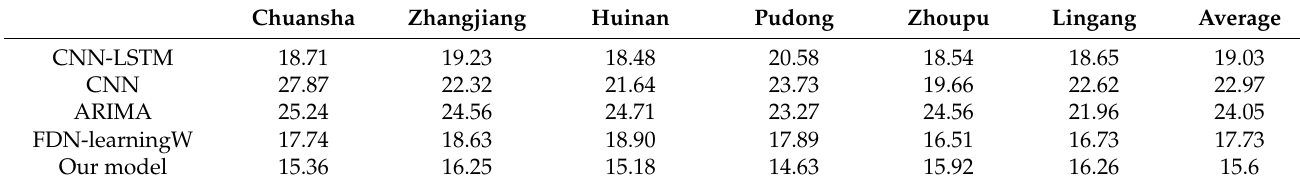
Table 5. Performance comparison of different models on MAAPE.